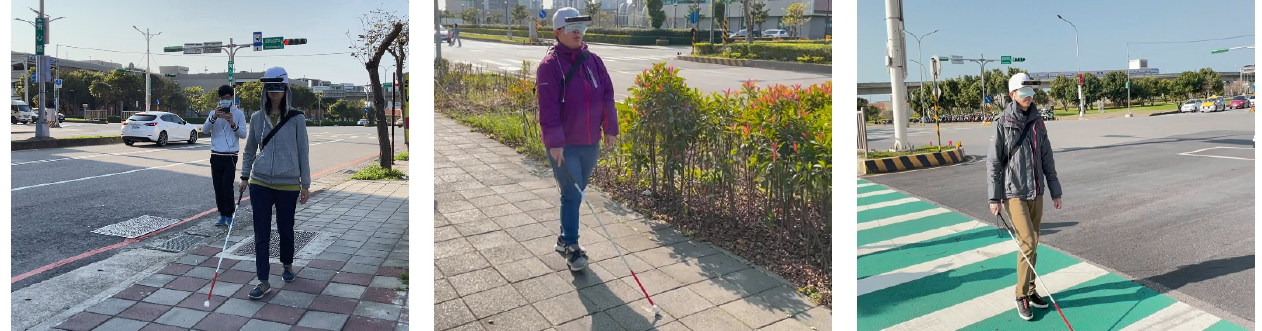
Figure 14. Experiments by students with blindfolds.